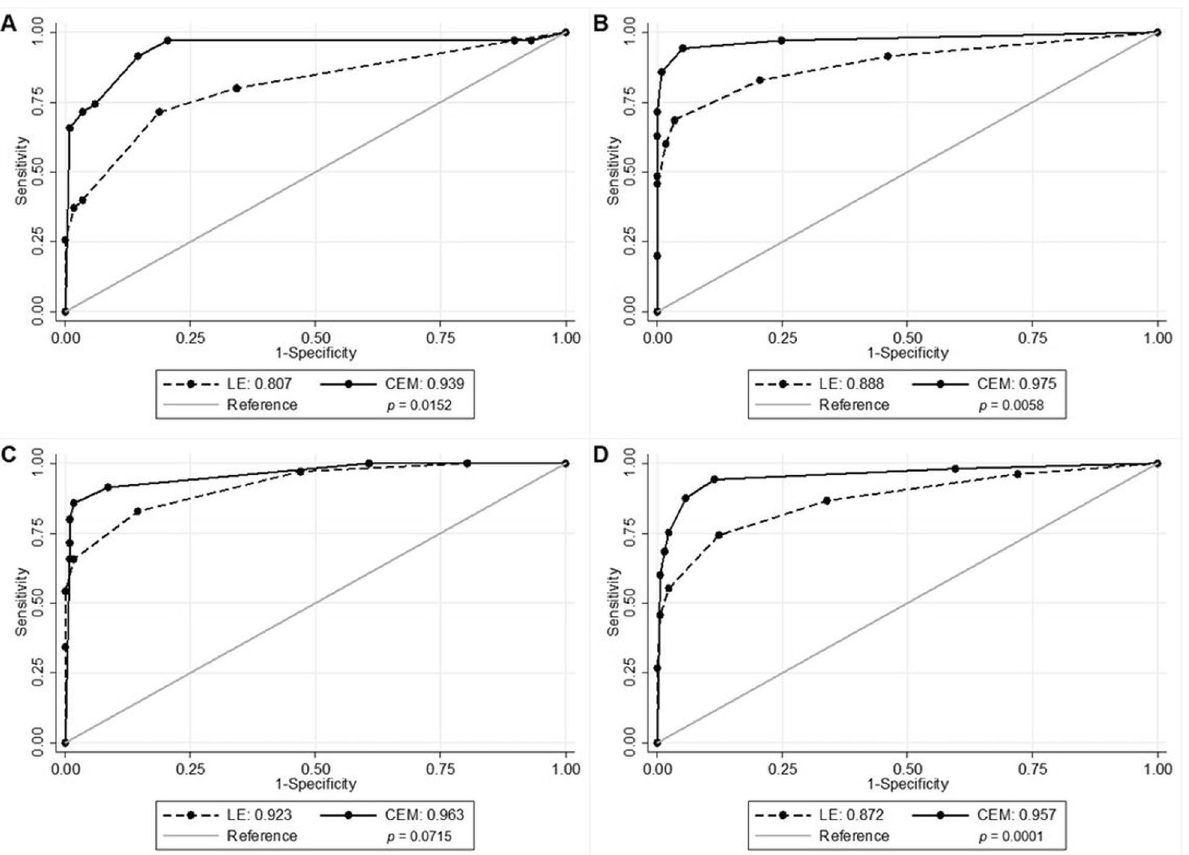
Figure 2. ROC curves and corresponding AUC values for LE and CEM, and p values. ( A ) Reader 1; ( B ) Reader 2; ( C ) Reader 3; ( D ) All readers combined. ROC Receiver operating characteristics, AUC Area under the curve, CI Confidence interval, LE Low-energy, CEM Contrast-enhanced